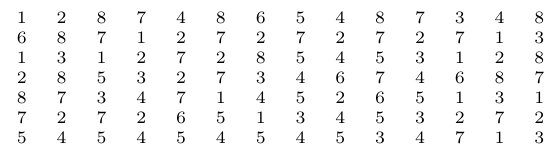
Table 3. Tiling map generated by the modified CSHD algorithm.